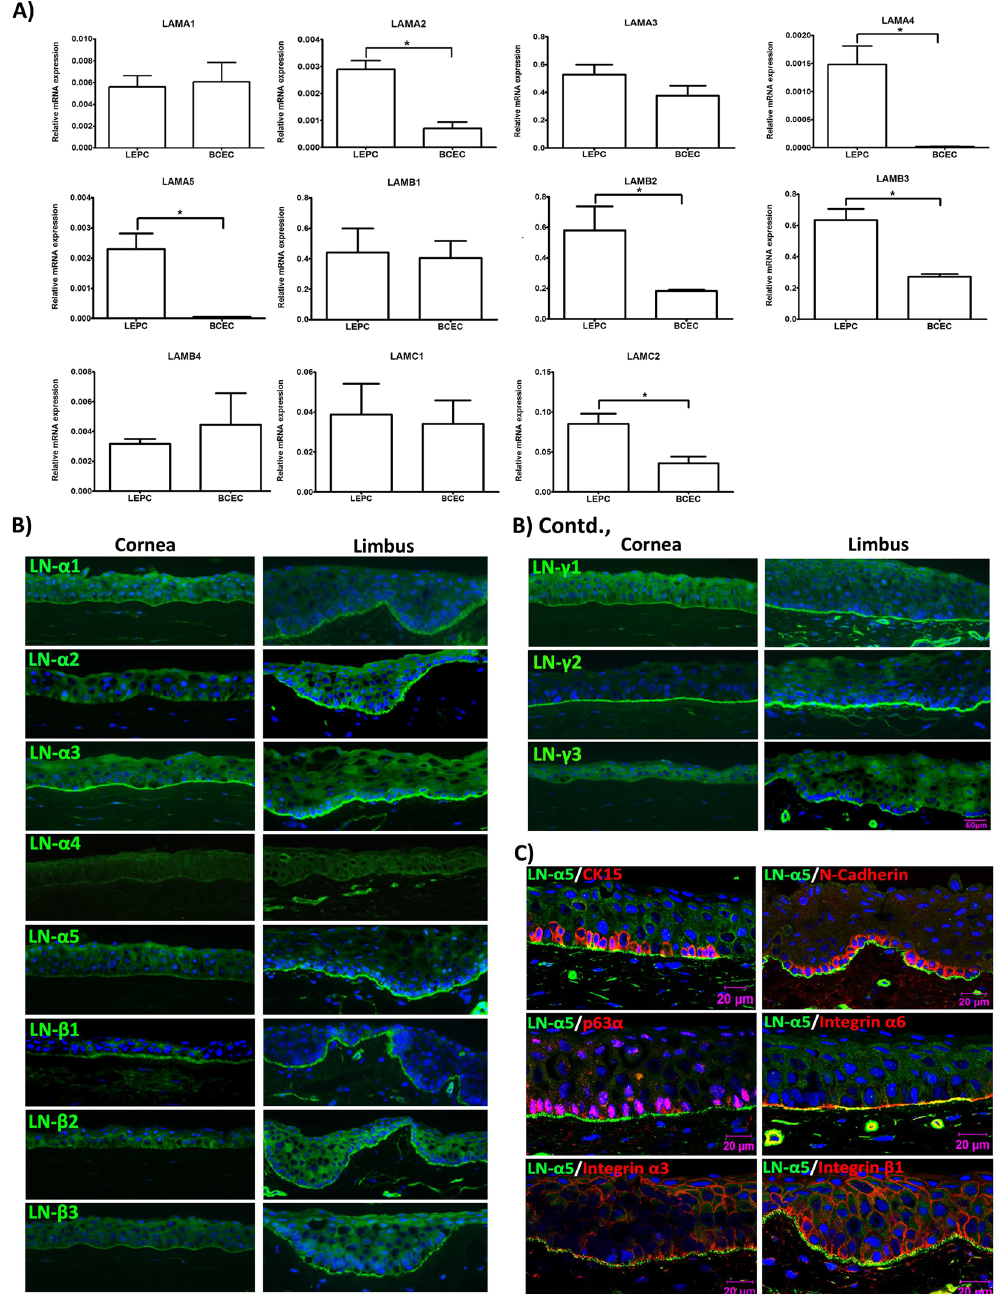
Figure 1. Expression of laminin chains in the limbal stem cell niche in situ . ( A ) Quantitative real-time polymerase chain reaction (qRT-PCR) primer assays showing higher expression levels of laminin α 2 (LAMA2), α 4 (LAMA4), α 5 (LAMA5), β 2 (LAMB2), β 3 (LAMB3), and γ 2 (LAMC2) in microdissected limbal epithelial stem/progenitor cell (LEPC) clusters compared with basal corneal epithelial cell (BCEC) populations; laminin α 1 (LAMA1), α 3 (LAMA3), β 1 (LAMB1), β 4 (LAMB4), γ 1 (LAMC1) showed no differential expression patterns. Data are expressed as means (2 −Δ CT × 1,000) ± SEM ( n = 5); * p < 0.05; Mann-Whitney U test. ( B ) Immunofluorescence analyses of corneoscleral tissue sections showing differential staining patterns of laminin α 2, α 5, β 2, β 3, γ 2, and γ 3, but similar staining patterns of laminin α 1, α 3, β 1, and γ 1 in the basement membranes of corneal and limbal epithelia; laminin α 4 was largely negative in epithelial basement membranes. Nuclei are counterstained with DAPI (blue); scale bar = 60 µ m. ( C ) Immunofluorescence double labeling of laminin (LN) α 5 (green) and cytokeration (CK)15, N-Cadherin, p63 α , integrin α 6, integrin α 3, and integrin β 1 (red); nuclear counterstaining with DAPI (blue); scale bar = 20 µ